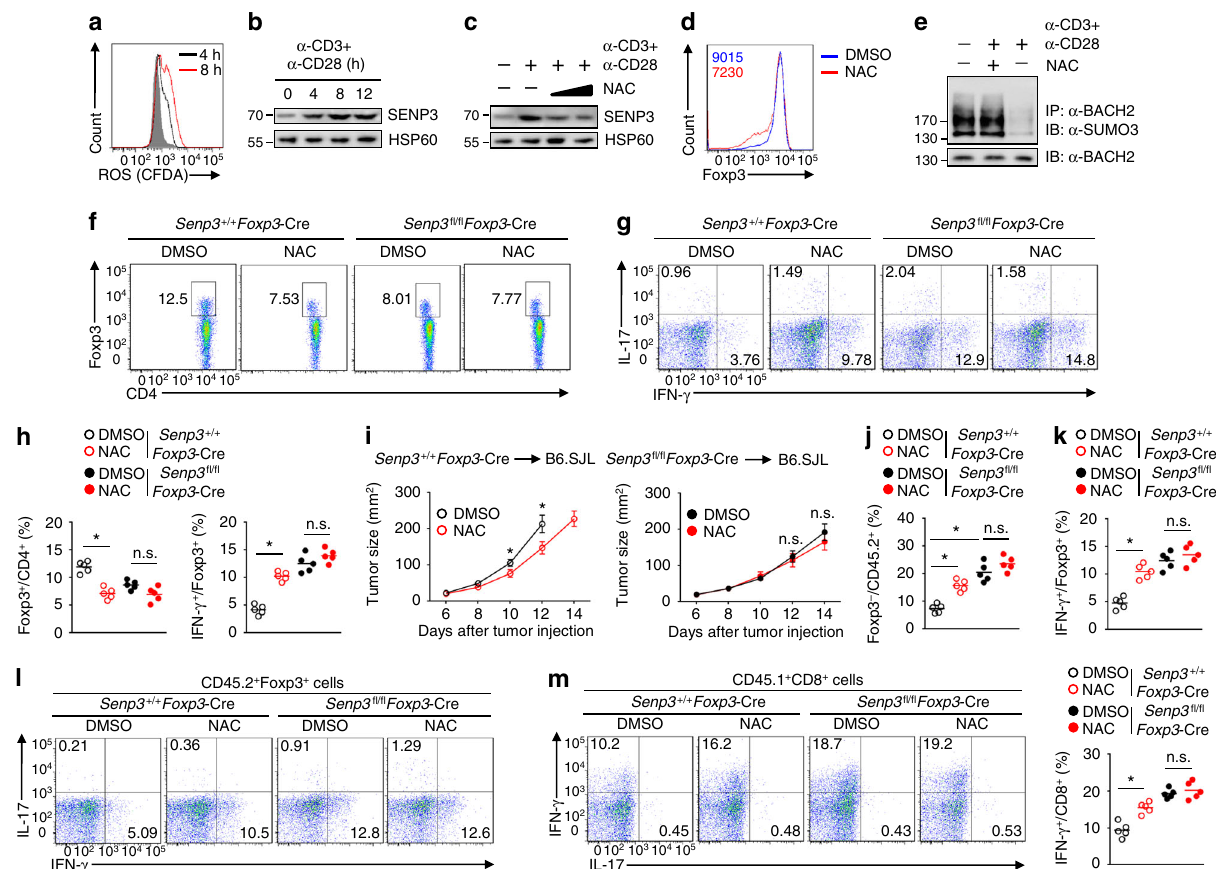
Fig. 7 ROS-induced SENP3 accumulation regulates Treg cell stability. a , b Levels of ROS ( a ) and SENP3 ( b ) in Treg cells stimulated with anti-CD3 and anti- CD28 antibodies for the indicated time periods. Grey area, unstimulated Treg cells. CFDA, CM-H2DCFDA. c SENP3 expression in Treg cells stimulated or not with anti-CD3 and anti-CD28 antibodies for 8 h in the presence or absence of 0.5 mM or 5 mM NAC. d Foxp3 expression in Treg cells stimulated with anti-CD3 and anti-CD28 antibodies for 12 h in the presence or absence of 5 mM NAC. e SUMOylation assays using Treg cells stimulated or not with anti- CD3 and anti-CD28 for 8 h in the presence or absence of 5 mM NAC. f – h Flow cytometric analysis of percentage ( f ) or IFN- γ and IL-17 expression ( g , h ) of tumor-in fi ltrating Treg cells from tumor-bearing Senp3 + / + Foxp3 -Cre and Senp3 fl / fl Foxp3 -Cre mice receiving daily NAC (on day 14). i – m B6.SJL mice were injected (s.c.) with B16-F10 cells and then intravenously (i.v.) treated (on day 6) with Senp3 + / + Foxp3 -Cre and Senp3 fl / fl Foxp3 -Cre Treg cells (2 × 10 6 cells per mouse) stimulated with anti-CD3 and anti-CD28 antibodies for 12 h in the presence or absence of 5 mM NAC. i Growth curves of tumors in B6.SJL mice ( n = 8 mice per group). j Percentage of tumor-in fi ltrating Foxp3 – CD45.2 + T cells (on day 14). k – m Flow cytometric analysis of IFN- γ and IL-17 expression in tumor-in fi ltrating CD45.2 + Foxp3 + ( k , l ) or CD45.1 + CD8 + ( m ) T cells (on day 14). Data are representative of three independent experiments and are presented as the mean ± SEM. n = 5 or 8. Two-tailed unpaired Student ’ s t tests were performed. n.s. not statistically signi fi cant; * P <